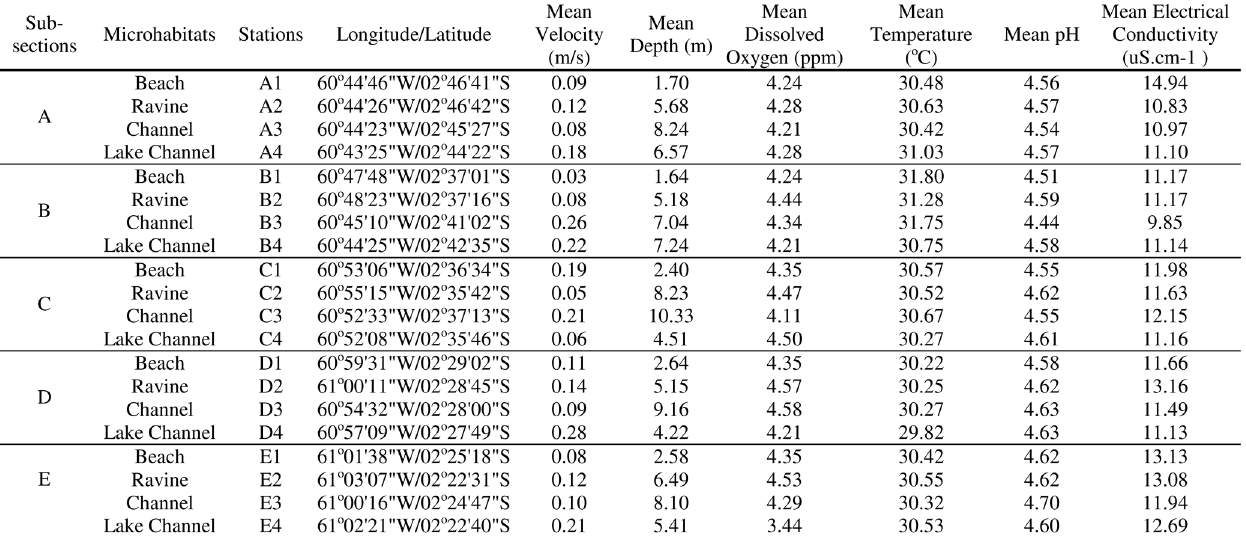
Table 1. Subsections, microhabitats, geographical location, hydrological and physicochemical data recorded in the Anavilhanas Ecological